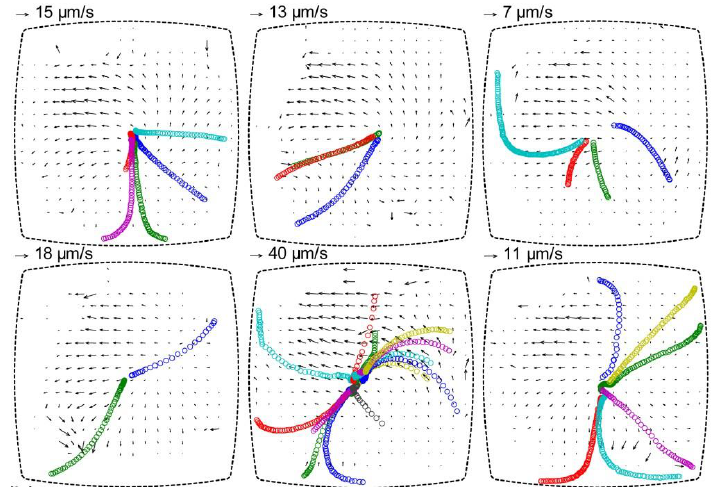
Figure 7. Particle tracking for estimation of acoustic radiation forces acting on 10 µm polystyrene particles, and particle image velocimetry (PIV) diagrams showing the background velocity field from acoustic streaming. The diagrams show the particle motion in the same well for six repetitions of the experiment after re-seeding the well with new particles. The tracks of 10 µm particles are indicated by circles (one color per individual particle), and the acoustic streaming is measured by with 1 µm particles used as flow trackers. The diagrams are based on a figure in Ref.